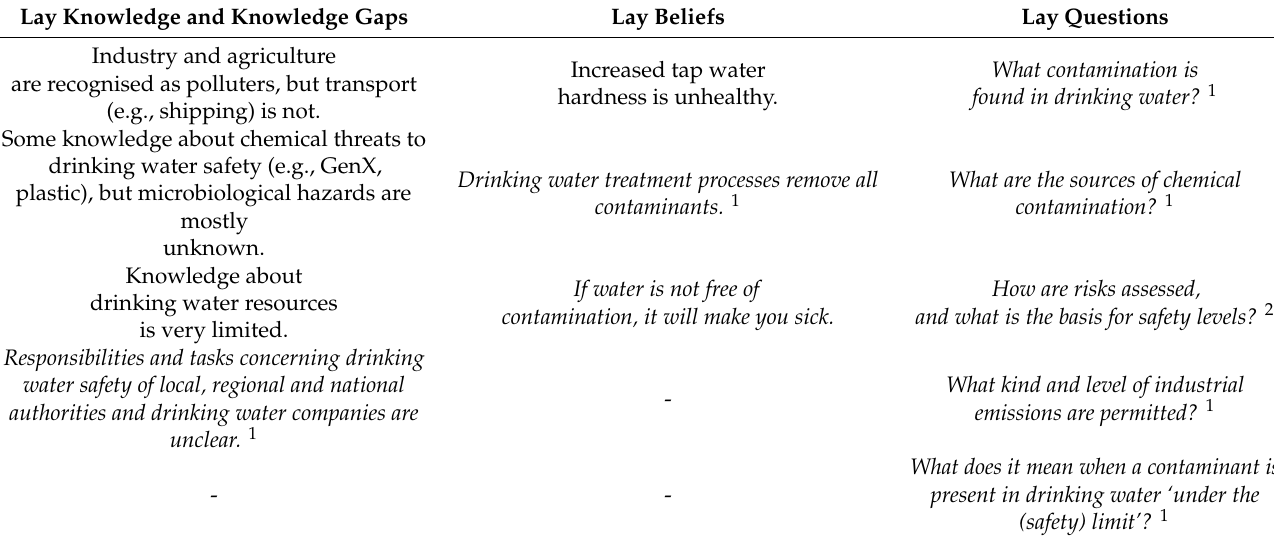
Table 1. Results from the comparison of the developed expert/stakeholders’ mental model and consumers’ mental model. Lay Knowledge and Knowledge Gaps Lay Beliefs Lay Questions Industry and agriculture hardness is unhealthy.